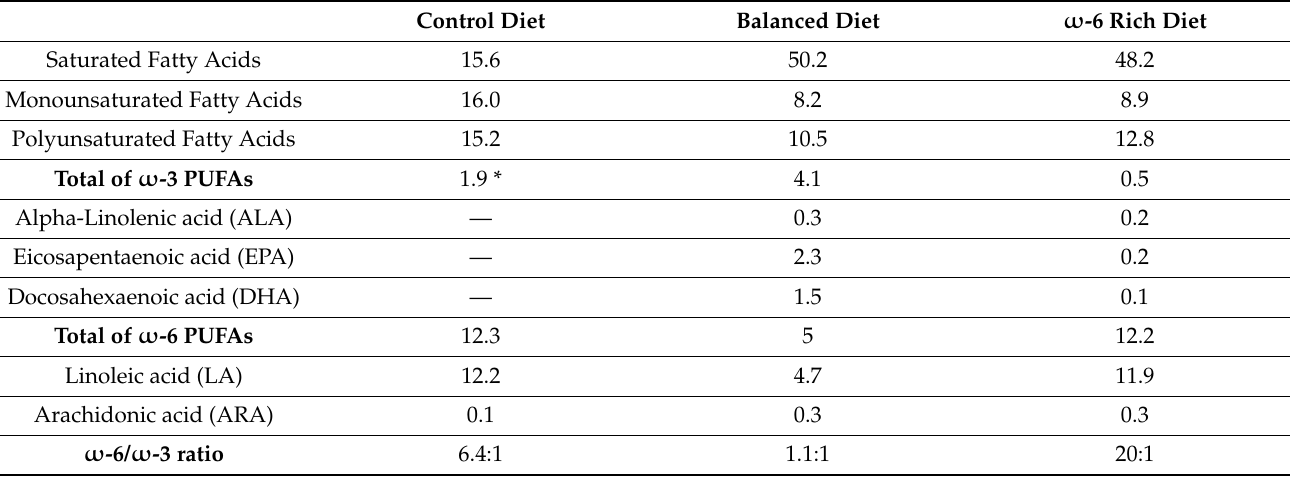
Table 3. Fatty acid composition of